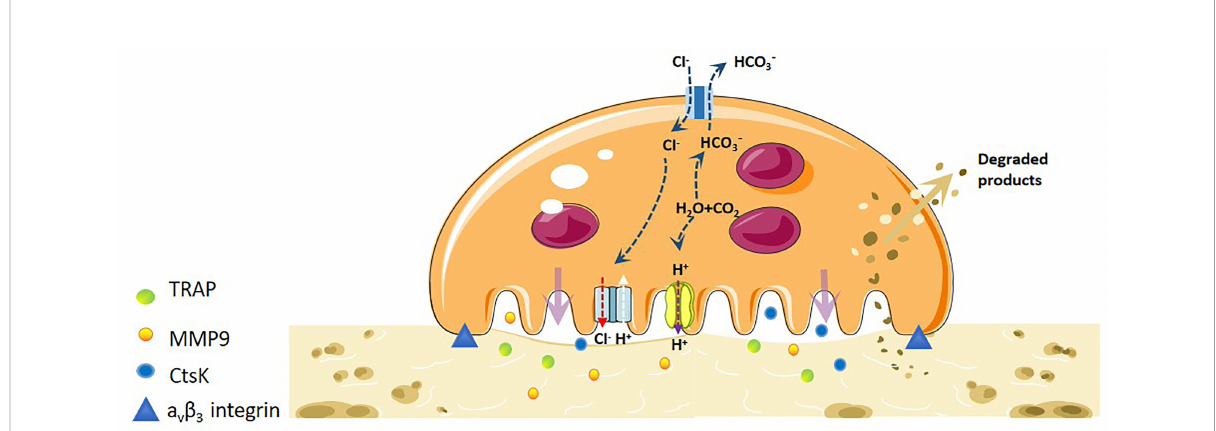
FIGURE 1 Mechanistic differentiation and function of OC under physiological conditions. OCs are the only osteolytic cells in vivo . It dissolves bone matrix in four steps. The fi rst step is OC adhesion. The integrin and actin micro fi laments expressed by OCs allows the cells to closely adhere to the bone surface and form a special cytoskeleton. The second step is OC polarisation, and the OC plasma membrane and cytoskeleton are recombined. The plasma membrane of OCs is divided into four different regions: basal region, wrinkle edge, sealing region and functional secretory region. The third step is degradation of bone matrix. H-ATPase transports H+ to the cavity, allowing the pH of the cavity microenvironment to near a pH of 4-6. This acidic environment loosens the minerals in the bone matrix, and the wrinkle edge also secretes protons and various bone resorption enzymes to degrade organic matter. The fourth step is the removal of degraded products. The degraded bone matrix products are transported from the fold edge to the functional secretory region through endocytosis, and then released